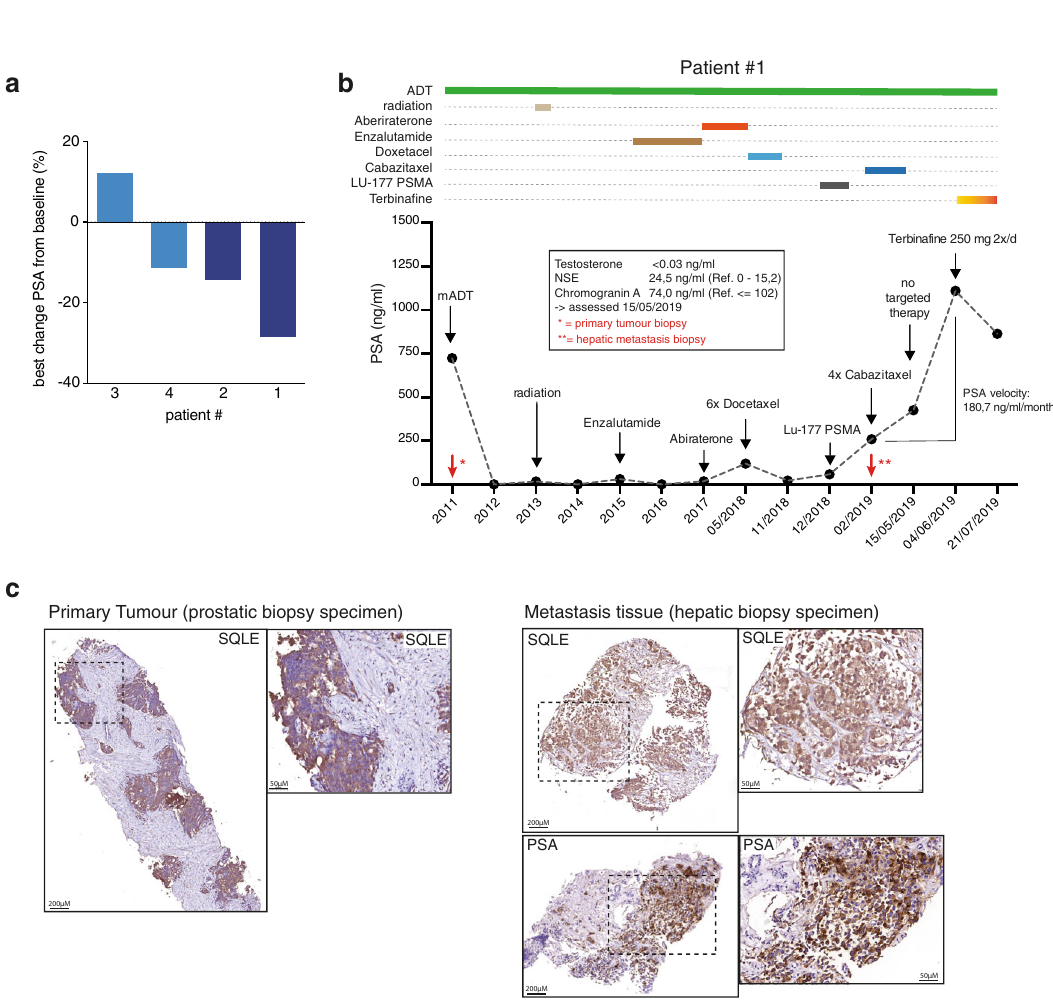
Fig. 8 SQLE inhibition by standard-dose terbina fi ne delays biochemical progression in patients with metastatic PCa. a Waterfall plot showing PSA percent change from baseline for four patients treated with either 500 mg/day (patients #1 and #4) or 250 mg/day (patient #2) for two weeks or 500 mg/day for six weeks (patient #3). b Serum PSA levels of patient #1 over the course of the disease. Respective treatment regimens are indicated above the graph. Inset: additional patient information. Red arrows indicate timepoints of tissue resection. c Representative images of IHC sections of tumour tissue stained for SQLE or PSA. Left: initial prostate biopsy specimen from 2011. Right: liver metastasis biopsy from May